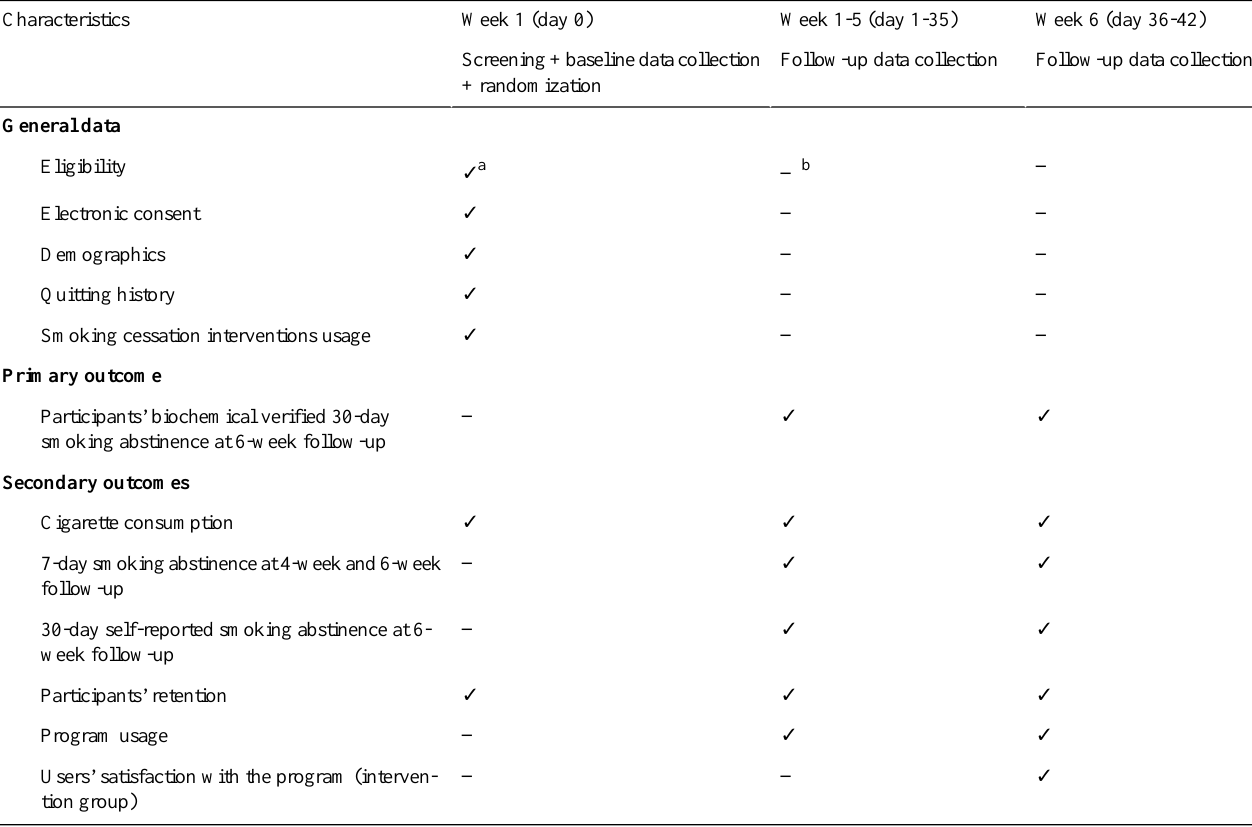
Table 3. Schedule of study data